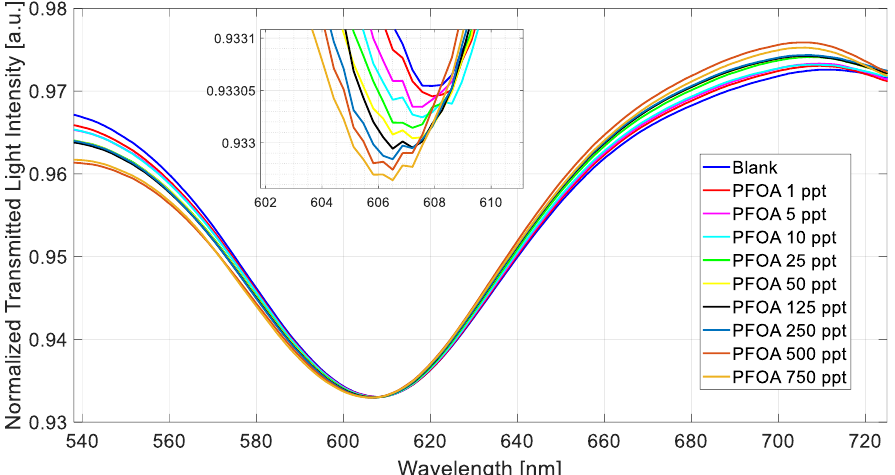
Figure 4. Normalized transmitted spectra obtained by fixing the refractive index (1.332) on the SPR – POF chip and increasing the PFOA concentration (range 1 – 750 ppt) in Milli-Q water upon the POF – chemical chip.